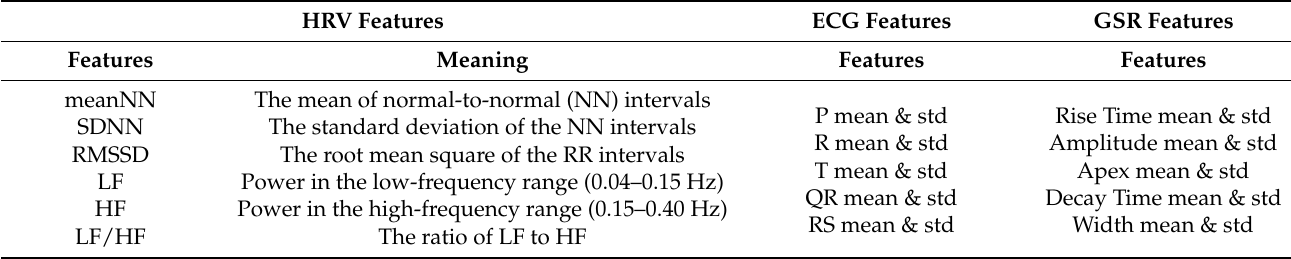
Table 1. HRV, ECG, and GSR features.